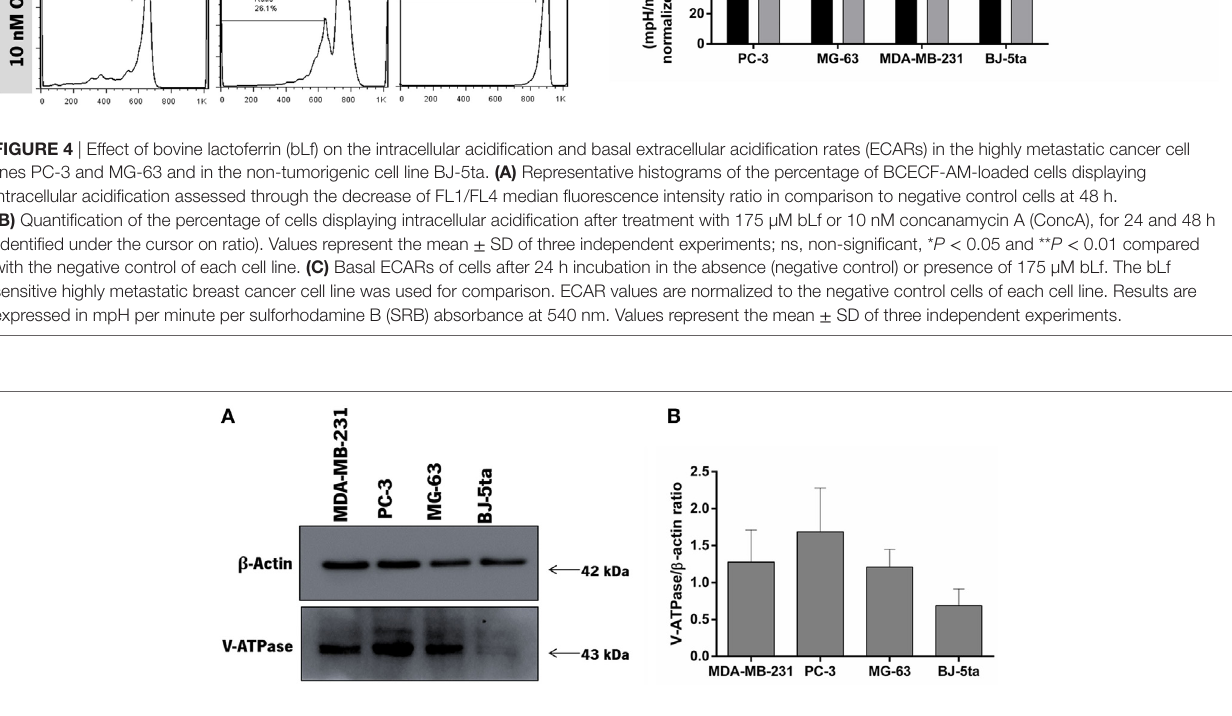
FigUre 5 | V-ATPase expression levels in highly metastatic prostate PC-3 and osteosarcoma MG-63 cancer cell lines in comparison with the highly metastatic breast cancer cell line MDA-MB-231 and the non-tumorigenic cell line BJ-5ta. (a) Representative western blot images of V-ATPase expression in each cell line using 35 µg of protein extracts in each lane. β -actin was used as a loading control. (B) Quantification of the levels of V-ATPase expression in the four cell lines normalized to the levels of β -actin. The values represent three independent assays.